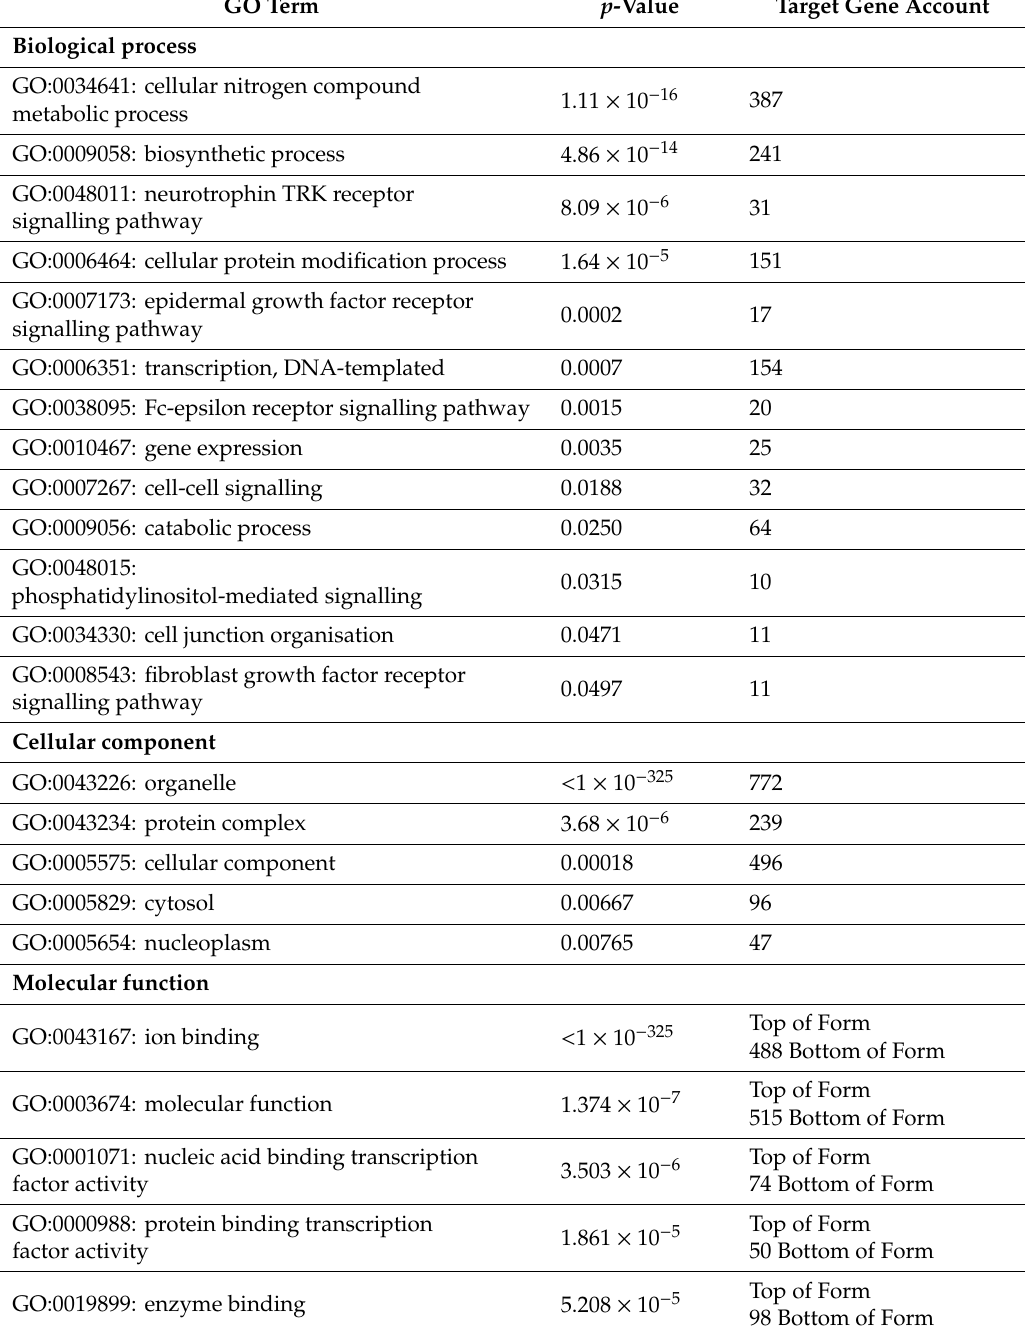
Table 4. Gene Ontology (GO) annotation results of the target genes of up-regulated microRNAs in breast cancer